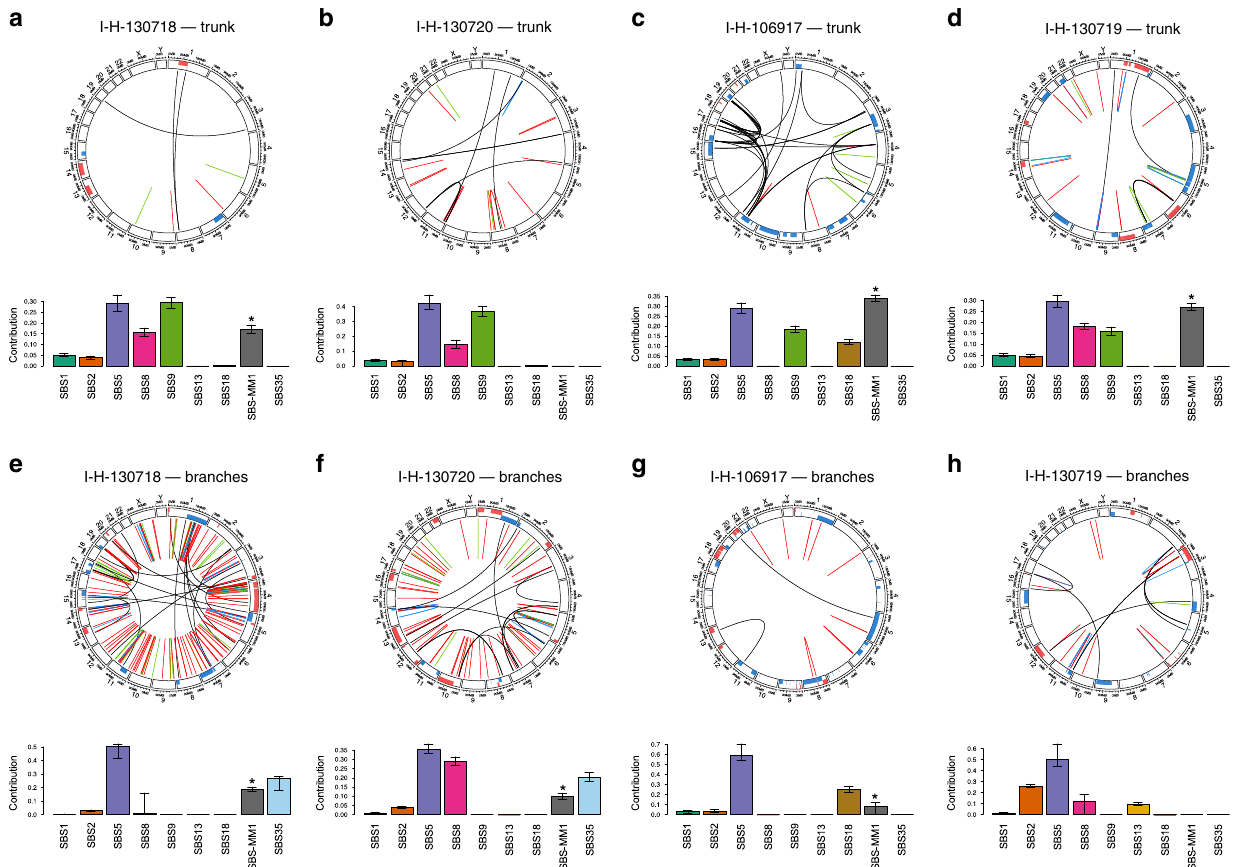
Fig. 4 Genome plot and mutational signature landscape of all four patients included in this study. The plots in the top row ( a – d ) show all the genomic events and mutational signatures shared by all samples in each patient (i.e., events in the trunk of the phylogenetic tree). The plots on the bottom row ( e – h ) show the events and mutational signatures not shared by all samples in each patient (i.e., events in the branches of the phylogenetic tree). Copy number aberrations are annotated in the periphery of the circos plots (blue = gain; red = loss of heterozygosity). Structural variants are reported within the circle (black = translocations; blue = inversions; green = tandem-duplications; red = deletions). The asterisks in the barplots re fl ect the presence of transcriptional strand bias for SBS-MM1 (melphalan-associated signature). Samples I-H-130718 and I-H-130720 were taken from the patients with short survival. Con fi dence interval of each mutational signature was generated by drawing 1000 mutational pro fi les from the multinomial distribution, each time repeating the signature fi tting procedure, and fi nally taking the 2.5th and 97.5th percentile for each